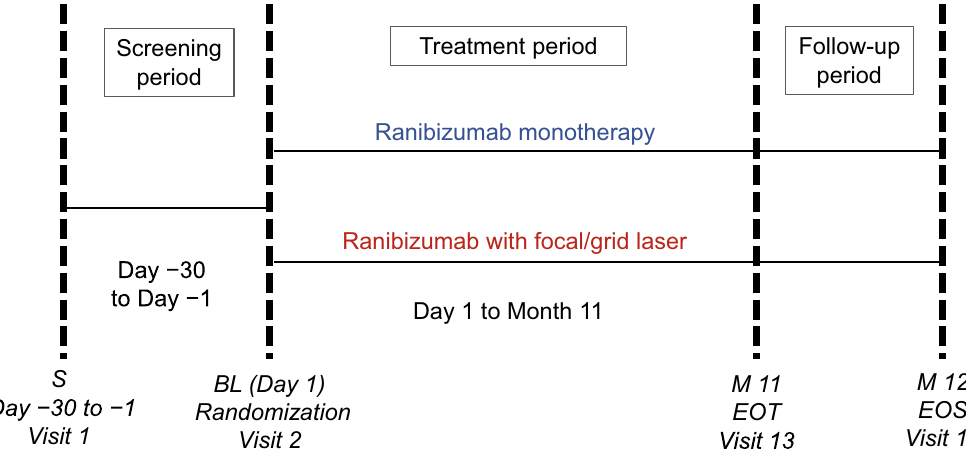
Figure 5. Design of the phase IV, randomized, open-label, active-controlled, 2-arm, multicenter ZIPANGU study. BL baseline, EOT end of treatment, EOS end of the study, M month, S